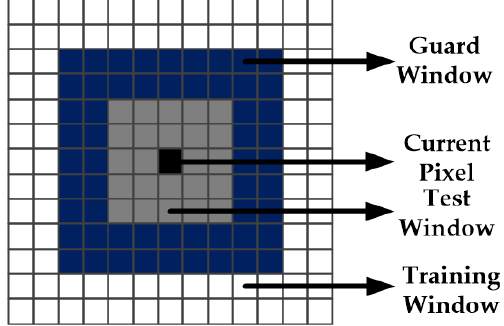
Figure 1. The configuration of guard filter.